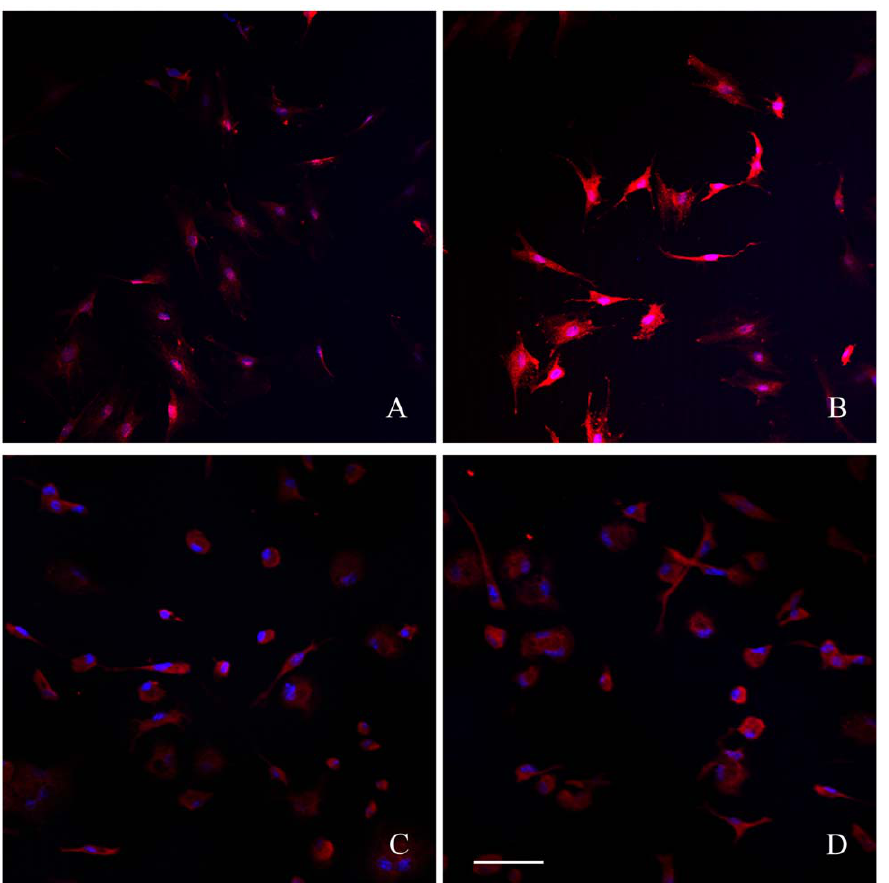
Figure 4. Immunofluorescence staining of MSCs, DCs and both cells in co-culture plates with IL-10. (A) Monoculture of MSCs. (B) MSCs in Transwell co-culture with DCs. (C) Monoculture of iDCs-LPS. (D) iDCs-LPS in Transwell co-culture with MSCs (MSC:DC=1:10). Red staining shows IL-10 expression; DAPI blue staining of cell nuclei. Scale bar 251658240=251658240100 m m.